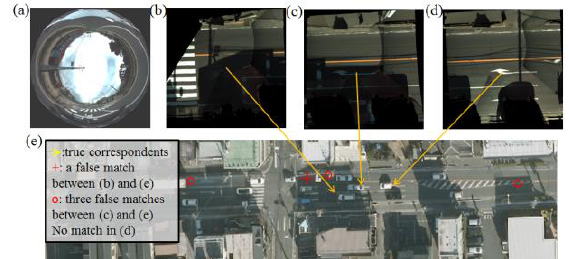
Figure 2. Matching difficulties and the multi-hypothesis